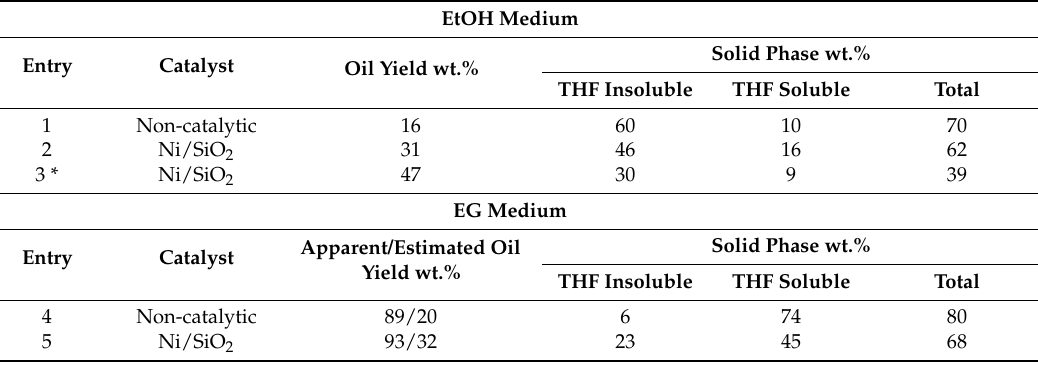
Table 3. Yields of the oil and solid fractions from conversion of H-LS over Ni/SiO 2 catalyst.